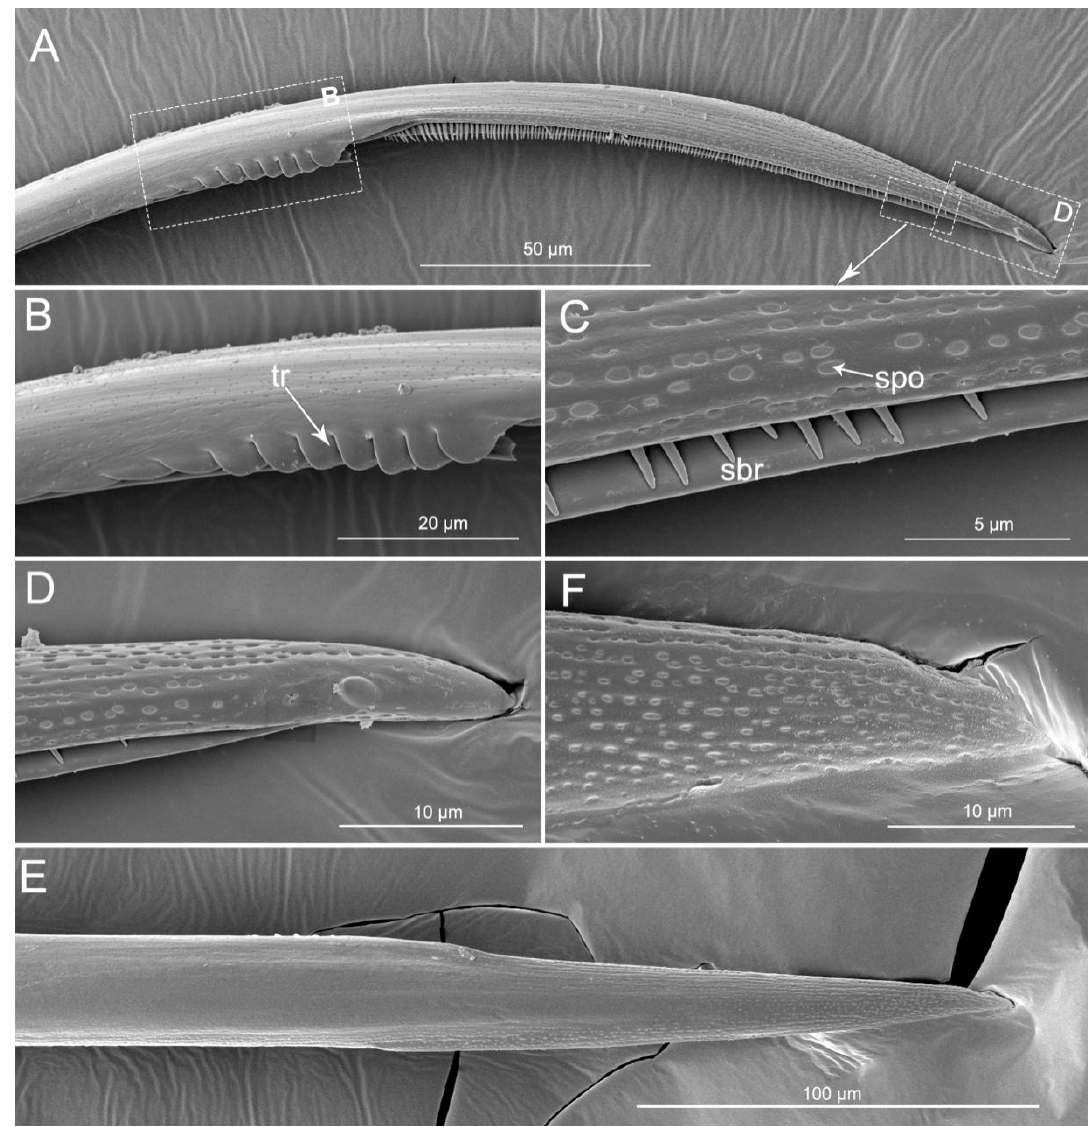
Figure 10. SEM of left maxillary stylets of Haematoloecha nigrorufa . ( A ). Lateral view; ( B ). Enlarged view of box in ( A ); ( C ). Enlarged view of box in ( A ); ( D ). Enlarged view of box in ( A ); ( E ). External view; F. Enlarged view of tip of left maxillary stylet; tr, transverse ridges; sbr, short bristles; spo, small pore.